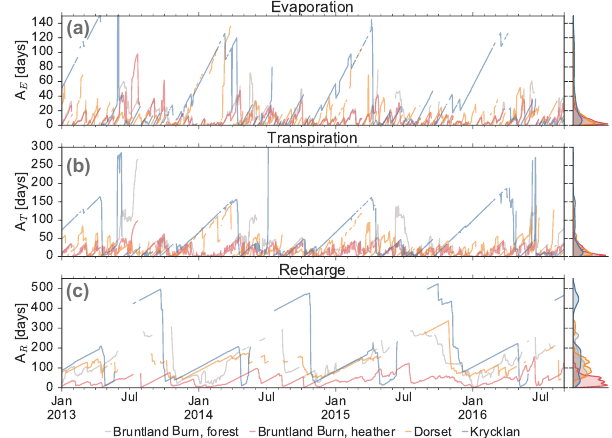
Figure 8. Median water ages of (a) evaporation ( A E ) , (b) transpira- tion ( A T ) , and (c) recharge flux ( A R ) . Note that when flux is zero, there is no water age for the flux. The colour code is according to the four study sites. Density distributions of the water ages are shown for each site on the right-hand